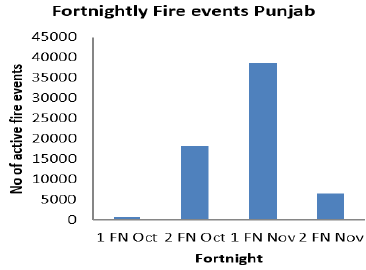
Figure 5a. Fortnightly comparison of active fire events in